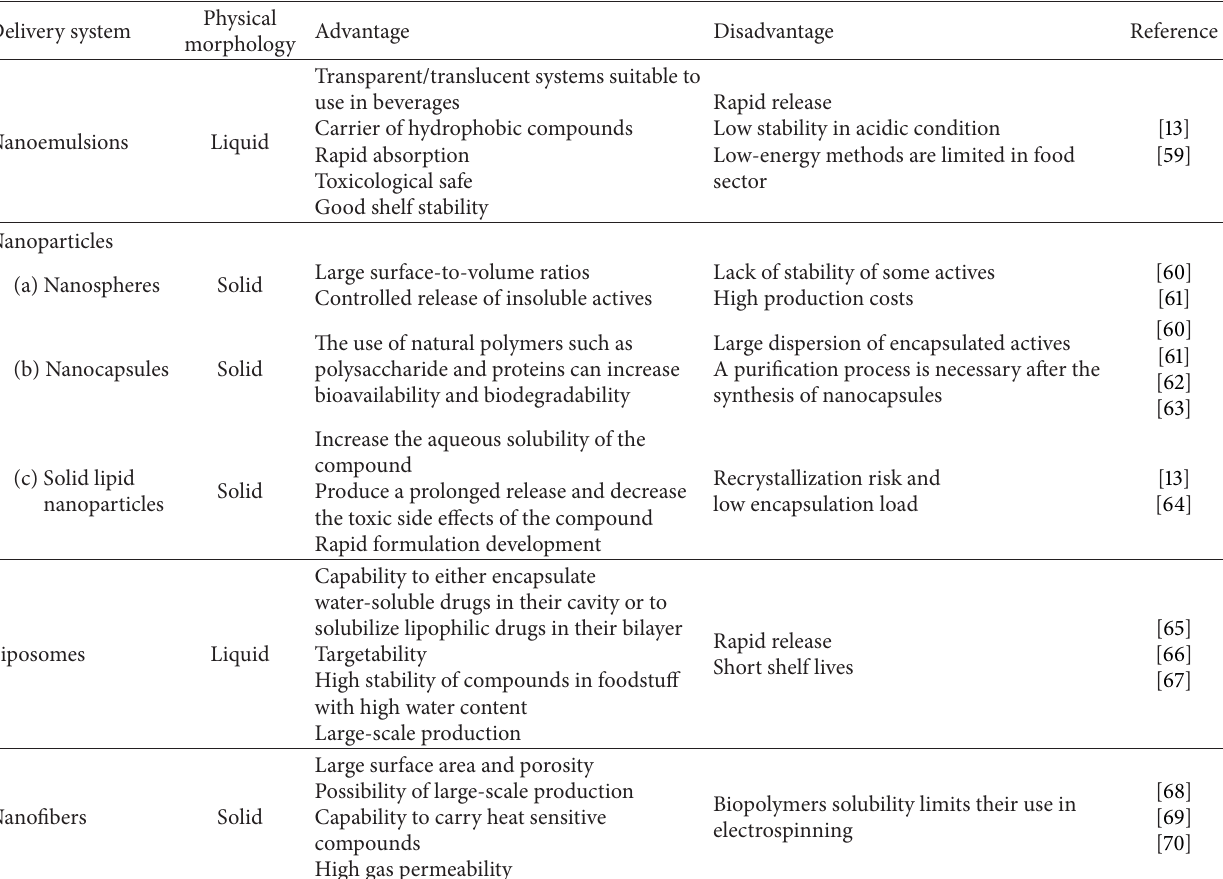
Table 1: Advantages and disadvantages of nanoencapsulated systems of food